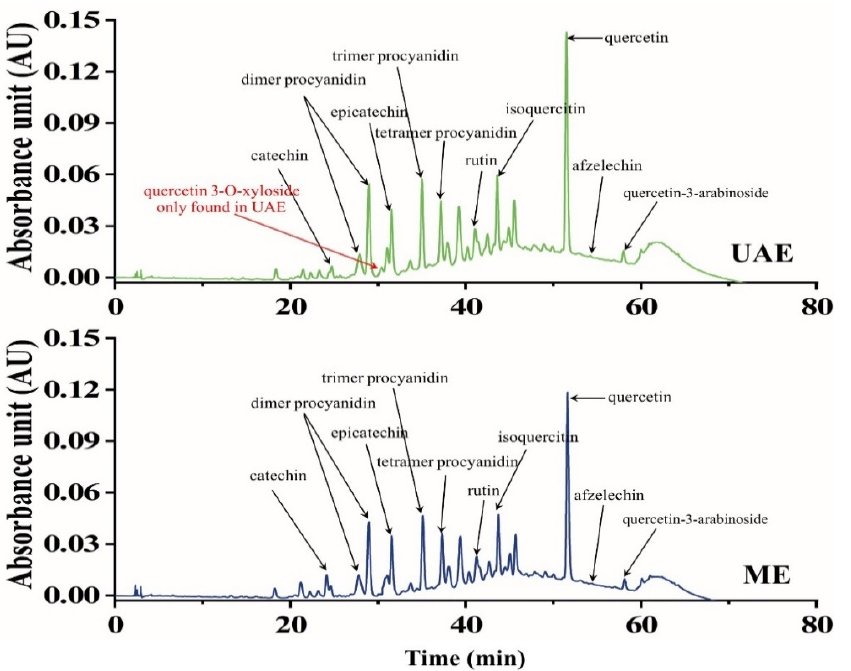
Figure 5. HPLC-QTOF-MS/MS spectra of the chemical composition differences between ultrasound-assisted extraction (UAE) and maceration extraction (ME) methods.